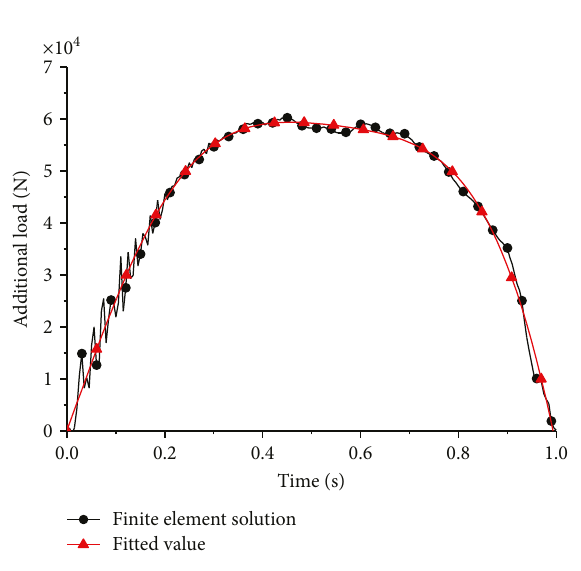
Figure 6: Additional load